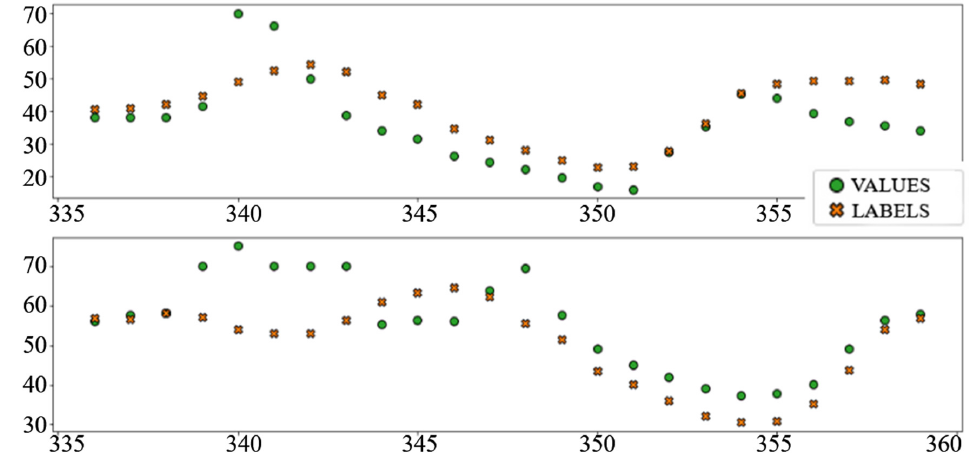
Figure 13. Price prediction examples: “LSTM”.